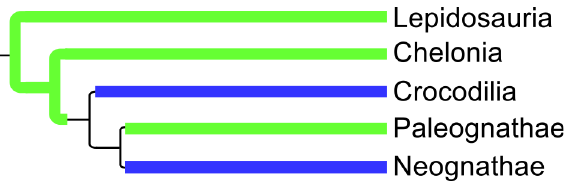
Fig 5. Summary of ancestral polygamy states for extant taxa. Green = both sexes polygamous, blue = socially monogamous, no colour = uncertain state.